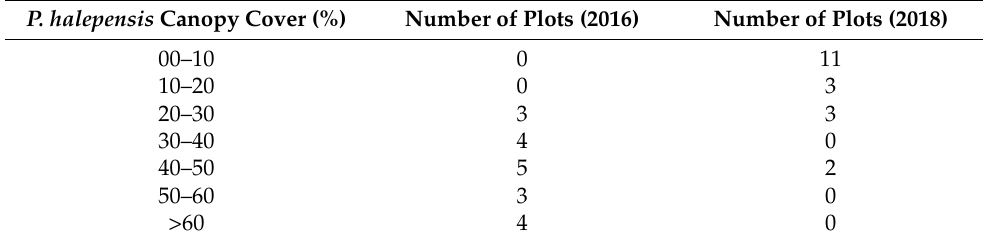
Figure 1. Study area location. Blue dashed line represents the Regional Park limits and the white dots highlight the survey plots (EPSG Projection 25830-ETRS89/UTM zone 30N). Table 1. Pine canopy cover ranges in the intervened plots before (2016) and after (2018) the experi- ment.